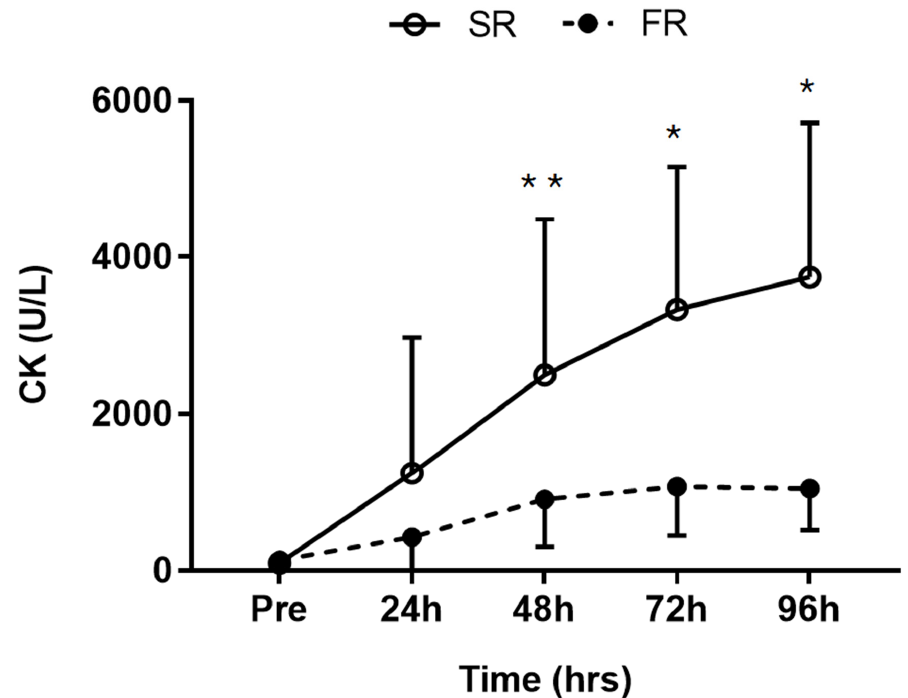
Figure 3. Changes in creatine kinase (CK) activity in response to strength recovery after eccentric exercise. SR refers to subjects (n = 8) with slower recovery ( < 40%), and FR refers to subjects (n = 8) exercise. SR refers to subjects (n = 8) with slower recovery (<40%), and FR refers to subjects (n = 8) with faster recovery ( > 80%). * Significant between groups ( p < 0.01), ** Significant between groups with faster recovery (>80%). * Significant between groups ( p < 0.01), ** Significant between groups ( p ( p < 0.05). Values are means ± SD. < 0.05). Values are means ± SD.